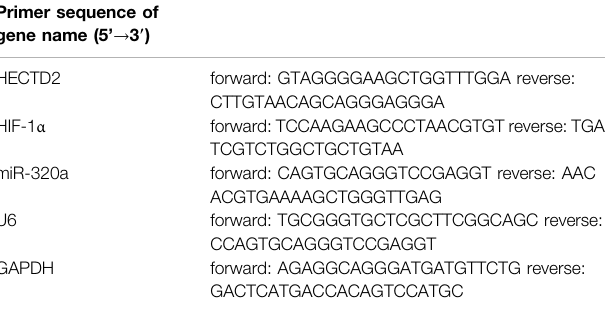
Primer sequence of gene name (5 ’ → 3 9 ) HECTD2 forward: GTAGGGGAAGCTGGTTTGGA reverse: CTTGTAACAGCAGGGAGGGA HIF-1